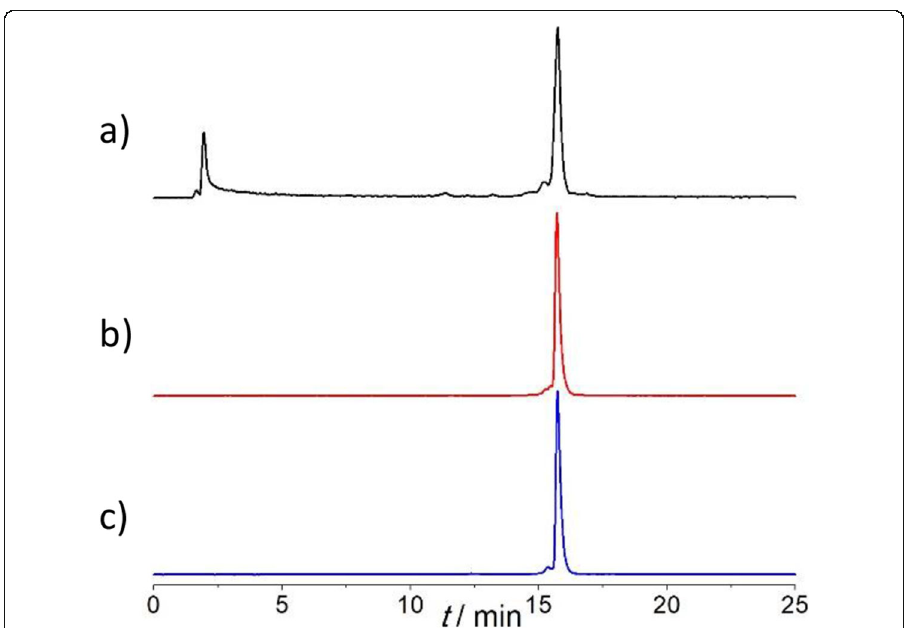
Fig. 6 Radio-HPLC chromatograms of ( a ) [ 64 Cu]Cu-DOTA-1Py- α MSH (RCY = 66%), ( b ) [ 64 Cu]Cu-DOTA-2Py- α MSH, and ( c ) [ 64 Cu]Cu-DOTA-3Py- α MSH